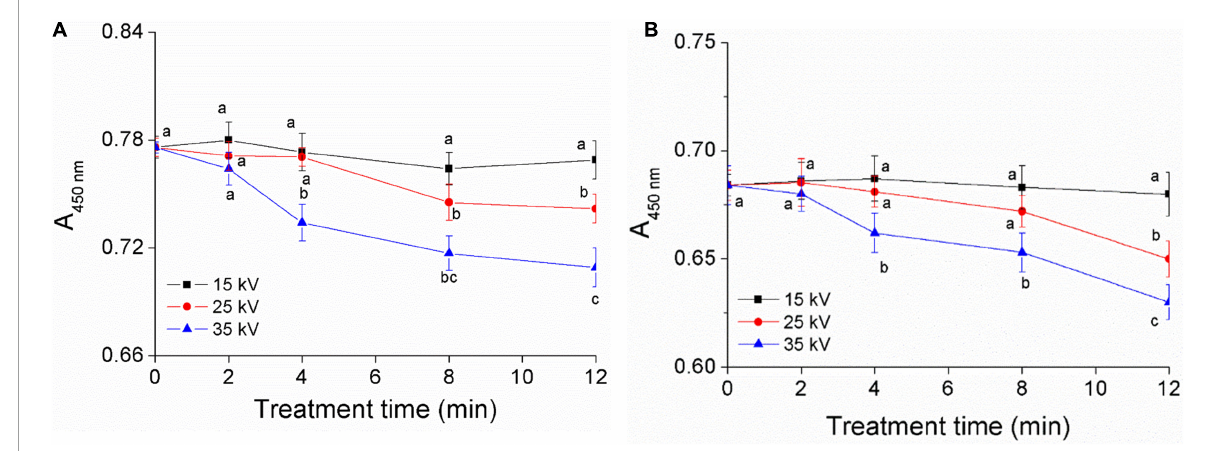
FIGURE2 Effect of DBD-ACP treatment on yellow pigment of foxtail millet. (A) Mizhi. (B)